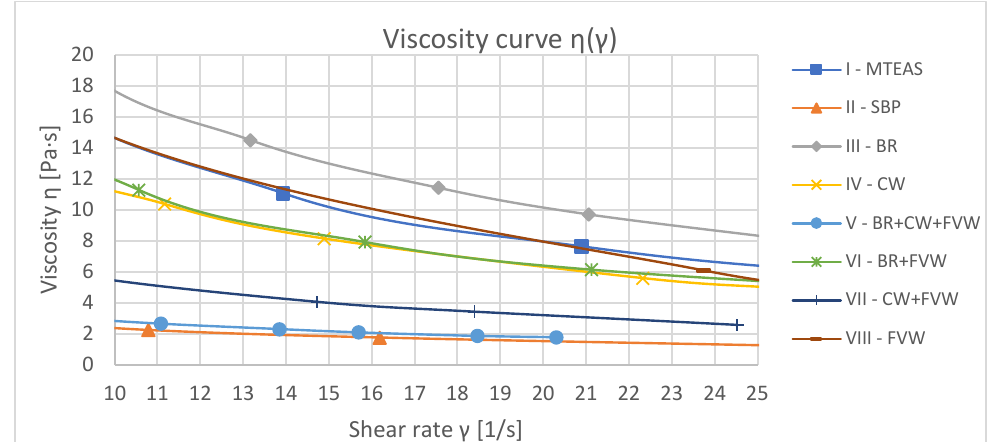
Figure 4. Viscosity curves for all samples — zoomed to the shear rate of 10–25 1/s.